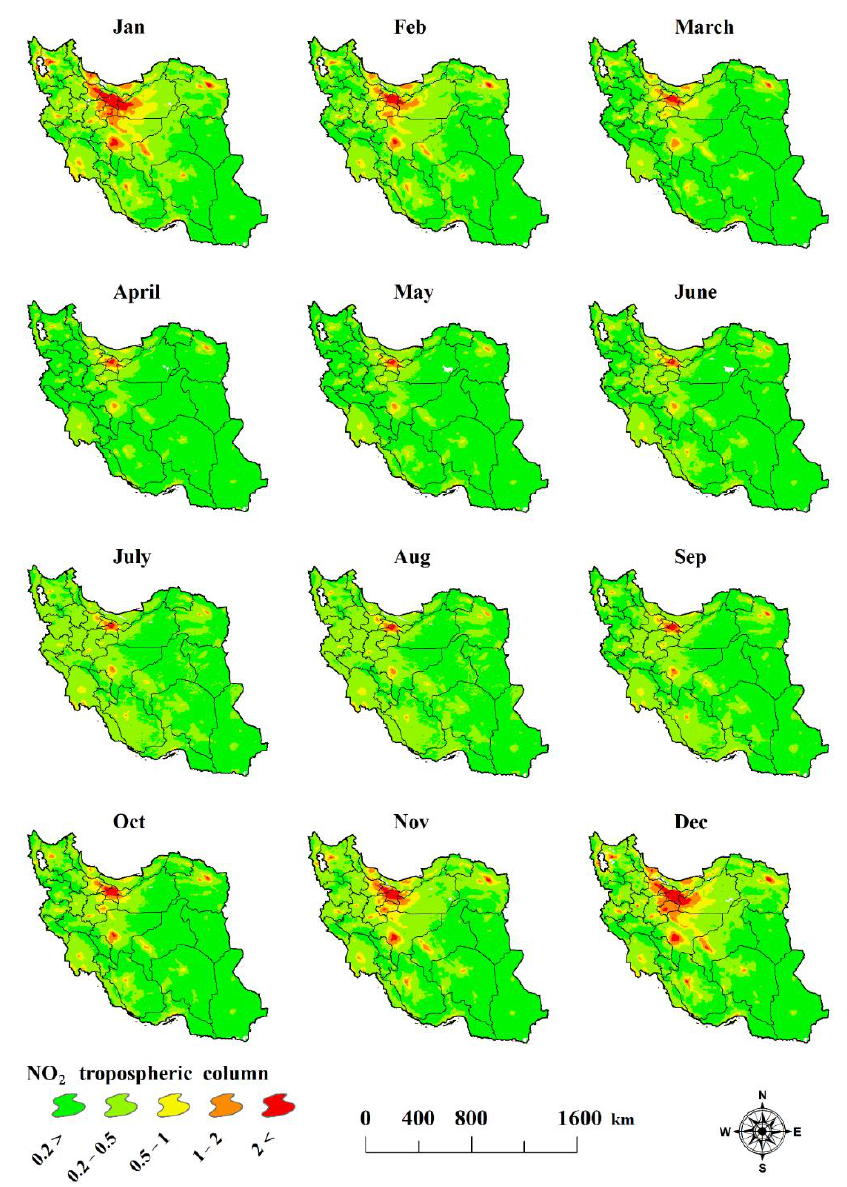
Figure 5. Iran’s monthly tropospheric NO 2 column concentration (10 15 molecules cm −2 ) (2018 – 2021).